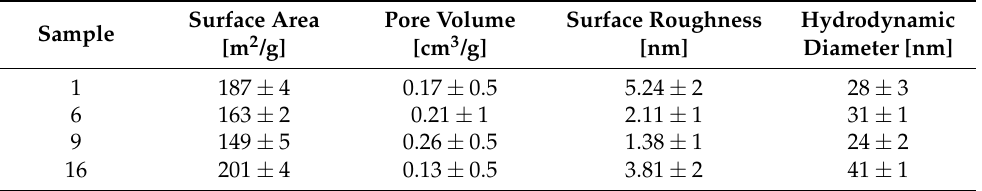
Table 2. Textural and microstructural properties of TiO 2 NPs.